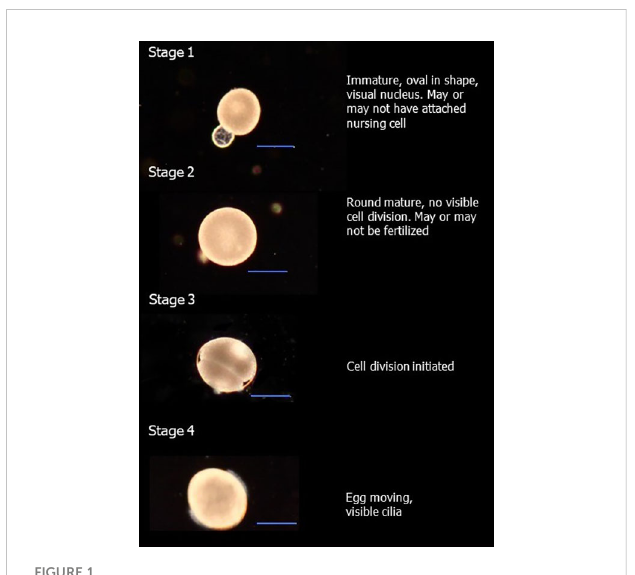
FIGURE 1 Developmental stages in eggs used for categorization during natural spawning ’ s. Scale bars represent 100